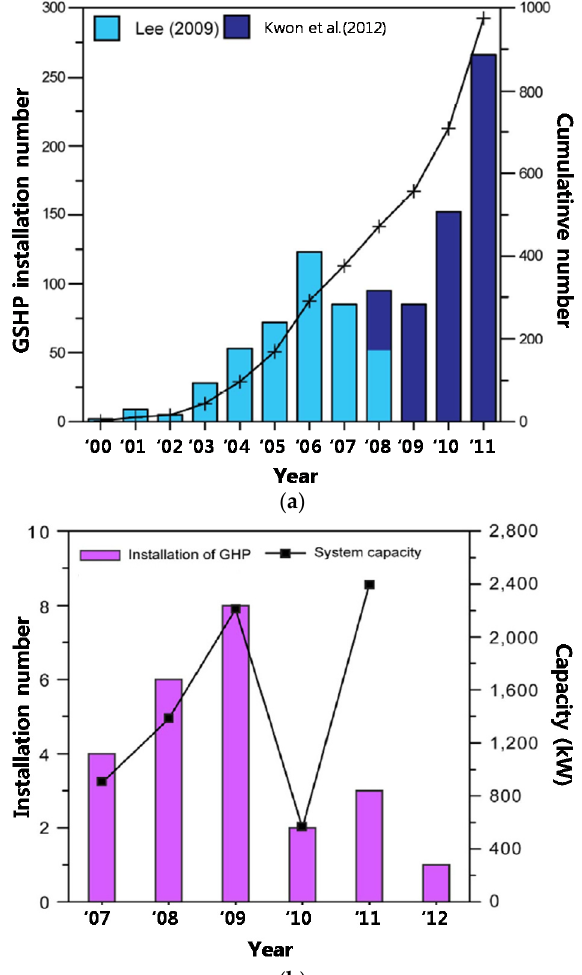
Figure 1. Current status of ground source heat pump system use in Korea. ( a ) Application of ground source heat pump systems; ( b ) Application of groundwater heat pump systems [3,4].